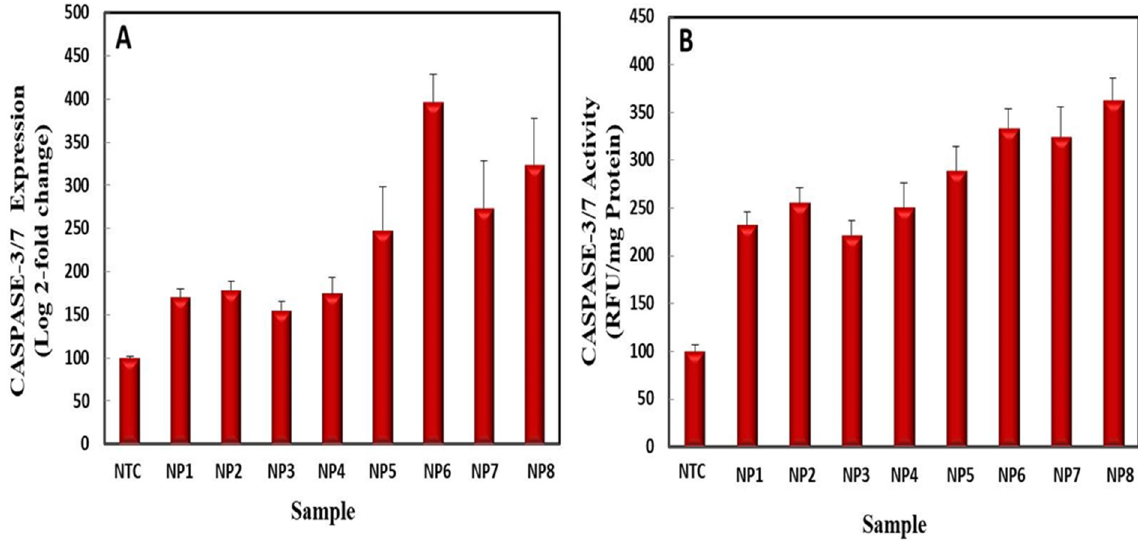
Figure 16. (A ) Caspase-3 gene expression in HepG2 cell lines. ( B ) Caspase-3/7 activity in HepG2 cells when exposed to monometallic and bimetallic NPs. Data represent the mean of 3 replicates ± SE. (Note—NTC: non-treated cells; NP1: control AgNPs; NP2: UV-C mediated AgNPs; NP3: control ZnONPs; NP4: UV-C mediated ZnONPs; NP5: control bimetallic Ag–ZnONPs (0.1/0.1); NP6: UV-C mediated bimetallic Ag–ZnONPs (0.1/0.1); NP7: control bimetallic Ag–ZnONPs (0.1/0.5); NP8: UV-C mediated bimetallic Ag–ZnONPs (0.1/0.5)).